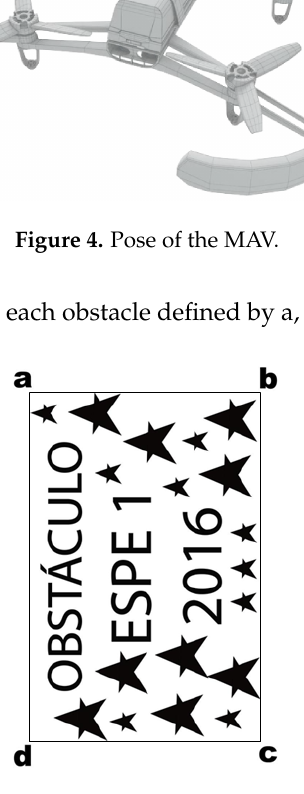
Figure 5. Corners of the